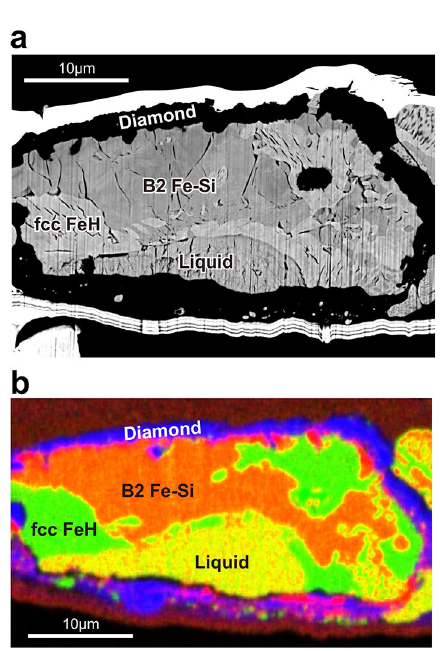
Figure 1. Sample XRD patterns collected at high pressures in ( a – e ) runs #1 to #5 before, during and after heating (melting). Asterisks indicate unknown peaks. See text for details.